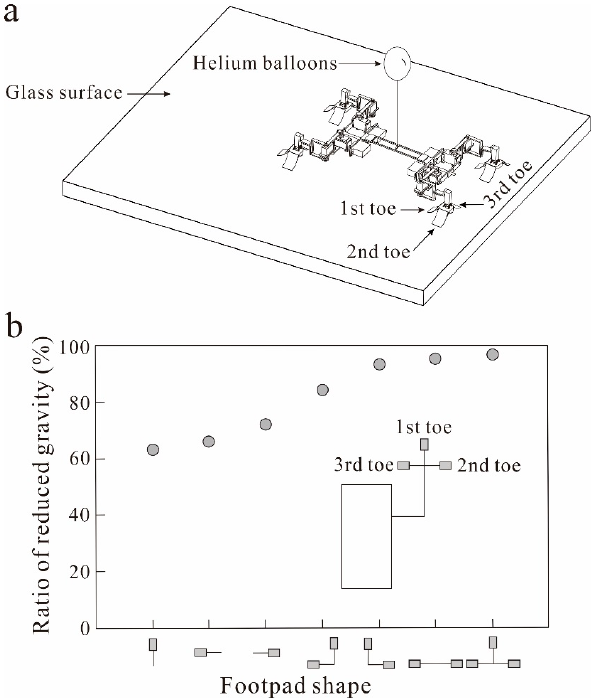
Figure 6. ( a ) Schematic of the robot climbing under reduced gravity; ( b ) Climbing ability with different footpad shape at different RRG.